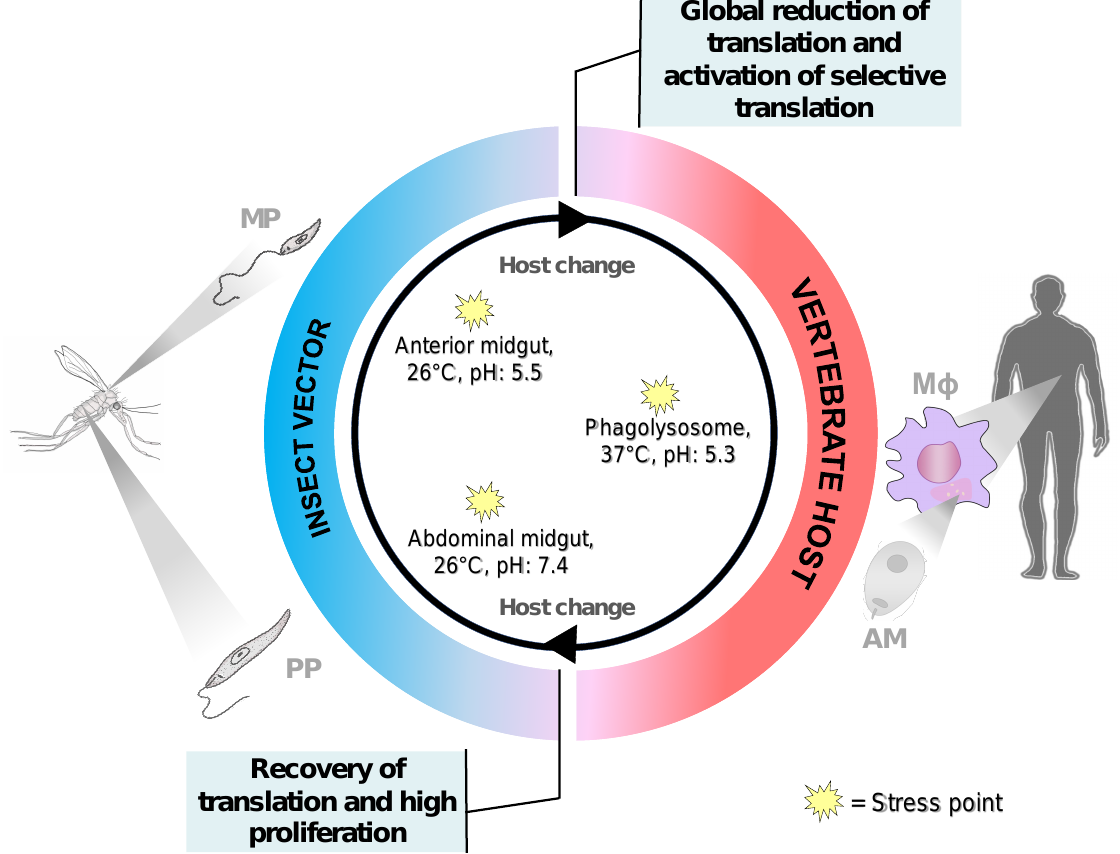
Figure 2. Regulation of translation at di ff erent stages of life cycle in Leishmania parasites. Leishmania parasites undergo dramatic changes in translation during host change. During transition from insect vector to vertebrate host, the changes in temperature, pH, and nutrition promote general translational repression via eIF2 α phosphorylation. At the same time selective translation is upregulated in amastigotes, to ensure parasite survival and adaptation in macrophages. In the sand fly, parasites experience a substantial drop in temperature and change in pH and nutrition. It promotes substantial increase in translation and amastigote di ff erentiation to highly proliferative promastigotes. M Φ , macrophage; PP, procyclic promastigotes; MP, metacyclic promastigotes; AM, amastigotes. Initiation of translation may play a big role in translational reprogramming when parasites enter a di ff erent host. Initiation of translation takes place through the binding of cap-binding protein eIF4E to the 5 0 cap structure, along with its binding partner eIF4G which serves as a sca ff old protein [20]. Then, a large ribosome subunit is recruited when the initiation complex reaches the first AUG [27]. Interestingly, the trypanosomatid genomes including Leishmania species have a large number of cap-binding complexes including six paralogs of eIF4E and five paralogs for eIF4G sca ff old protein [30–35]. The presence of many paralogs with di ff erent cap-binding activities and expression profiles during the life cycle of the parasite suggest that each paralog has evolved to perform a di ff erent biological function and a very complex regulation of gene expression, during the initiation of translation to support parasite survival under constantly changing environments. However, the precise role of these proteins in Leishmania parasites remains unclear and requires further investigation.